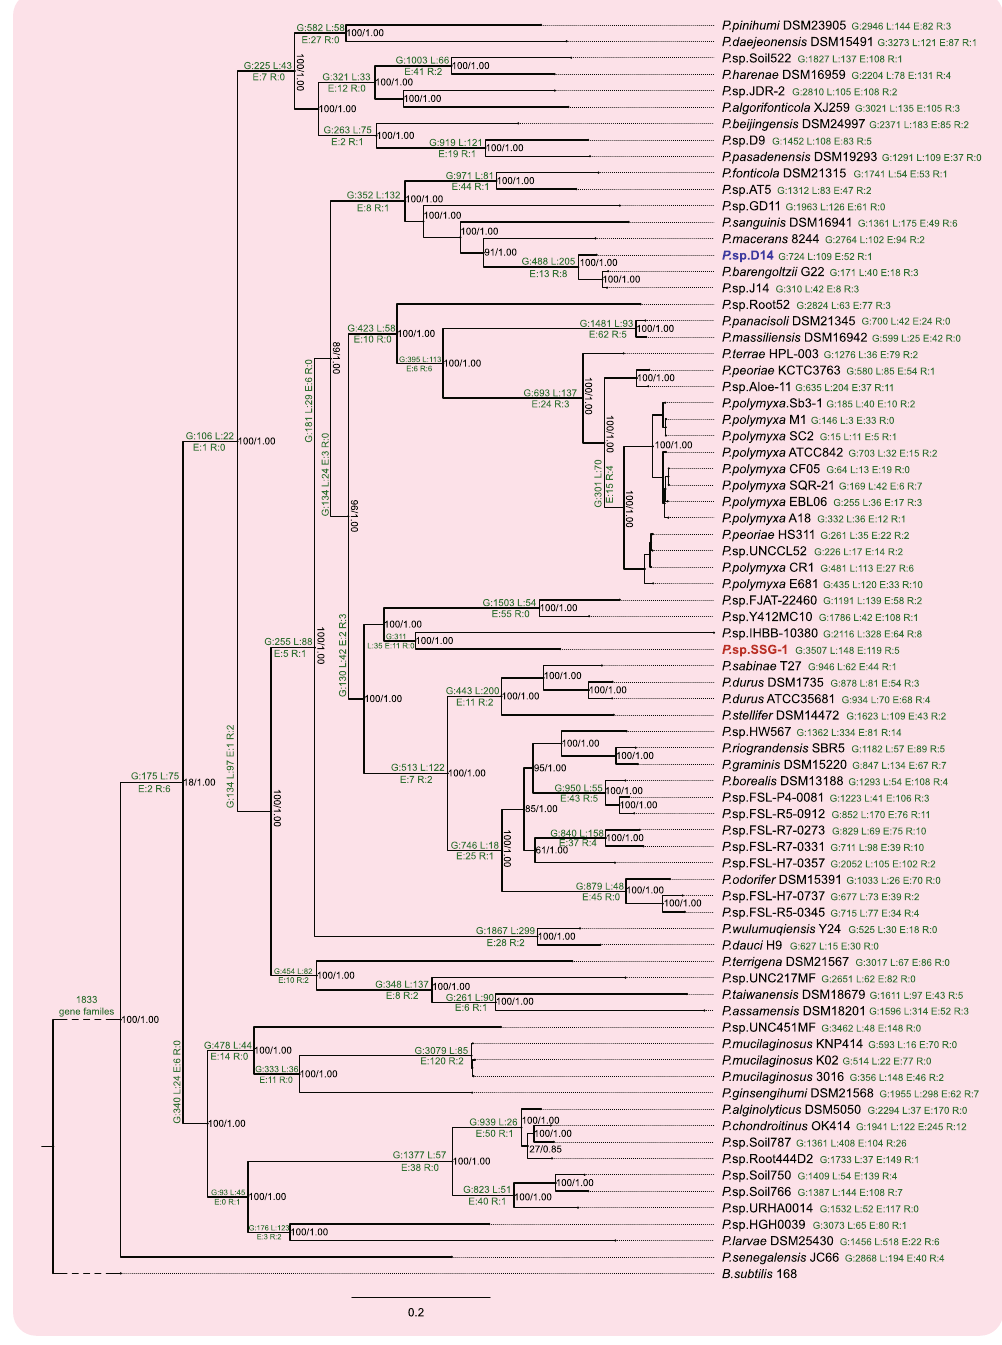
Figure 3. Phylogenetic tree of Paenibacillus . The numbers in nodes denote the bootstrap value (maximum 100) and Bayesian posterior probability (maximum 1.00). The numbers in branches denote the numbers of four categories of the change events (G: gain; L; loss; E: expansion; R: reduction). Numbers in short branches or in crowded nodes are